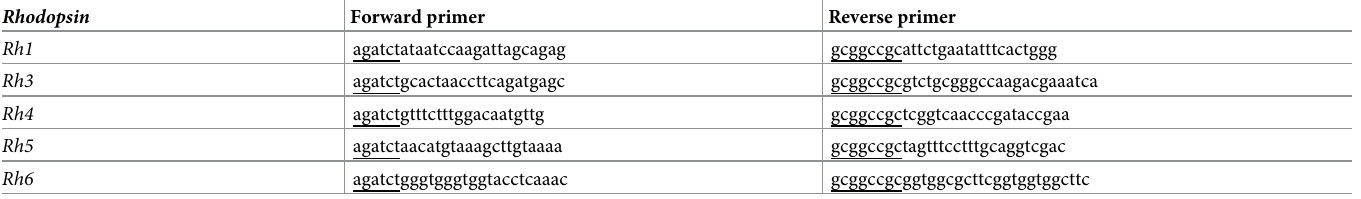
Table 1. Primers for generating minimal rhodopsin promoters and hybrid promoters. The minimal rhodopsin promoters have been previously described [19]; the underlined sequences are BglII or NotI restriction sites that we used for cloning.